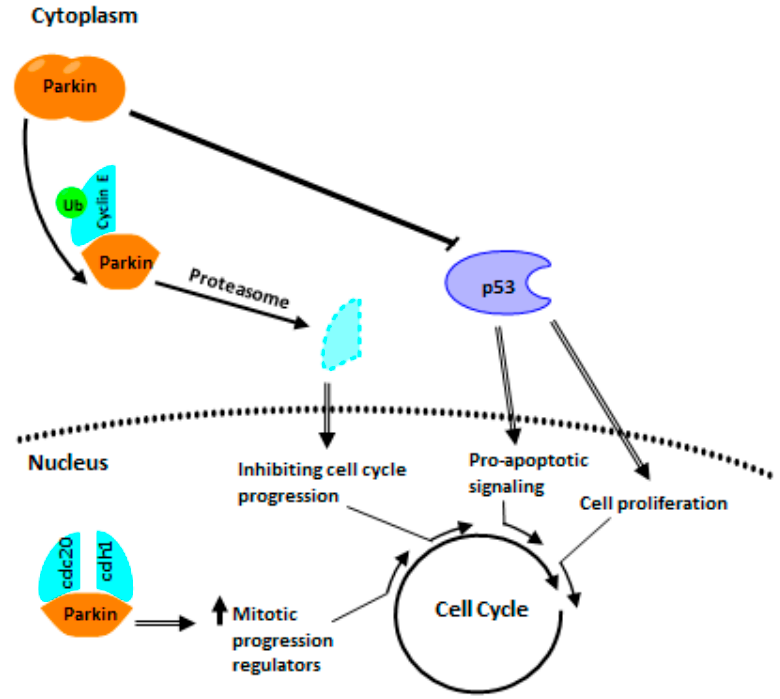
Figure 1. Graphical representation of the interactions of the PARKIN proteins. The directionality and the nature of the interactions (activation or inhibition) are shown as they are believed to exist in a healthy